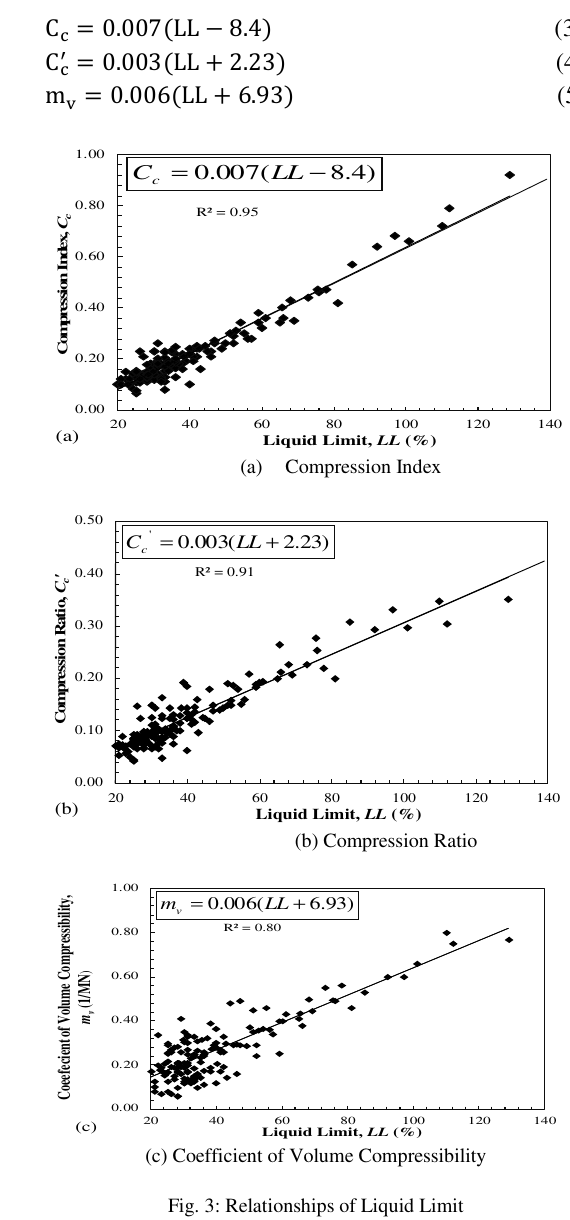
Fig. 3: Relationships of Liquid